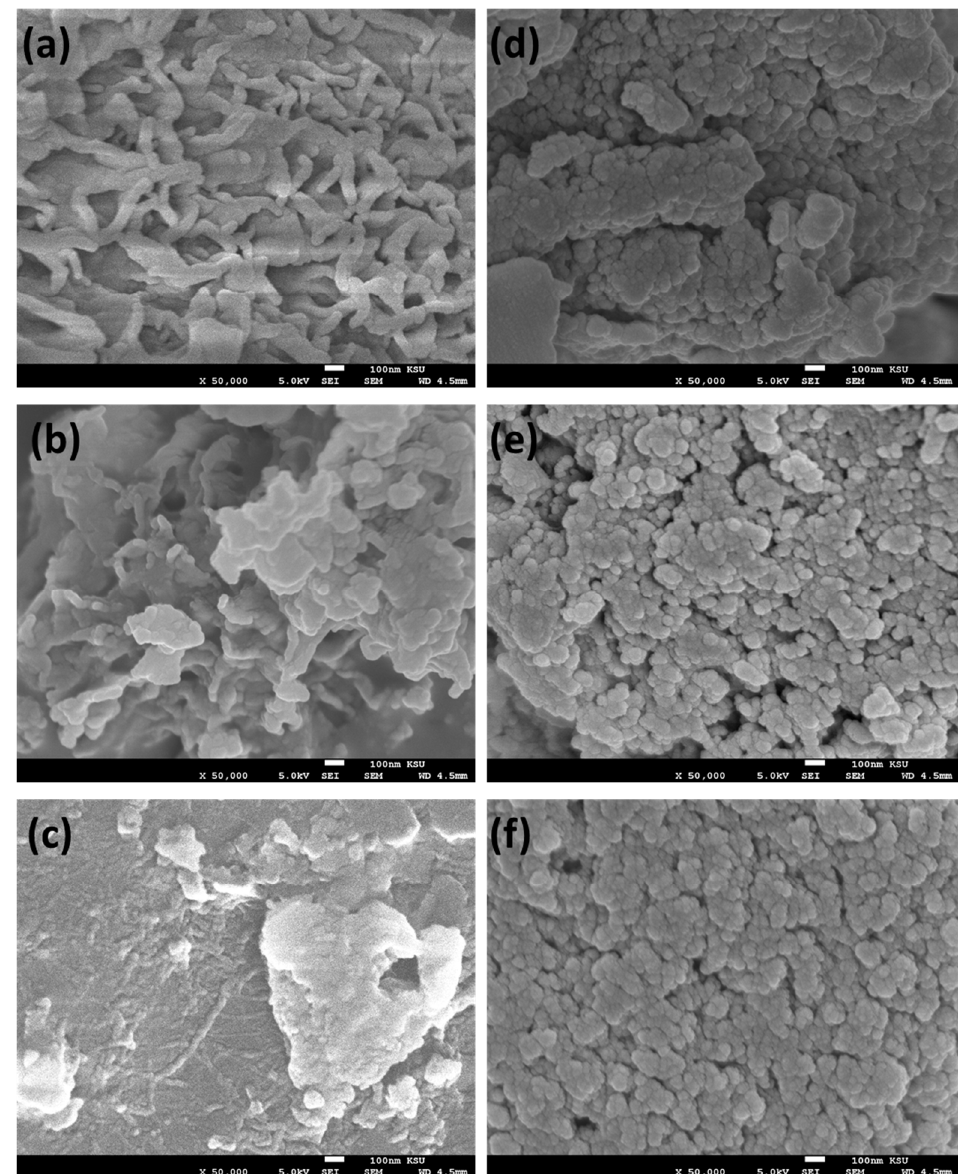
Figure 5. SEM images of samples ( a ) 5a, ( b ) 5b, ( c ) 5c, ( d ) 7a, ( e ) 7b, and ( f ) 7c.